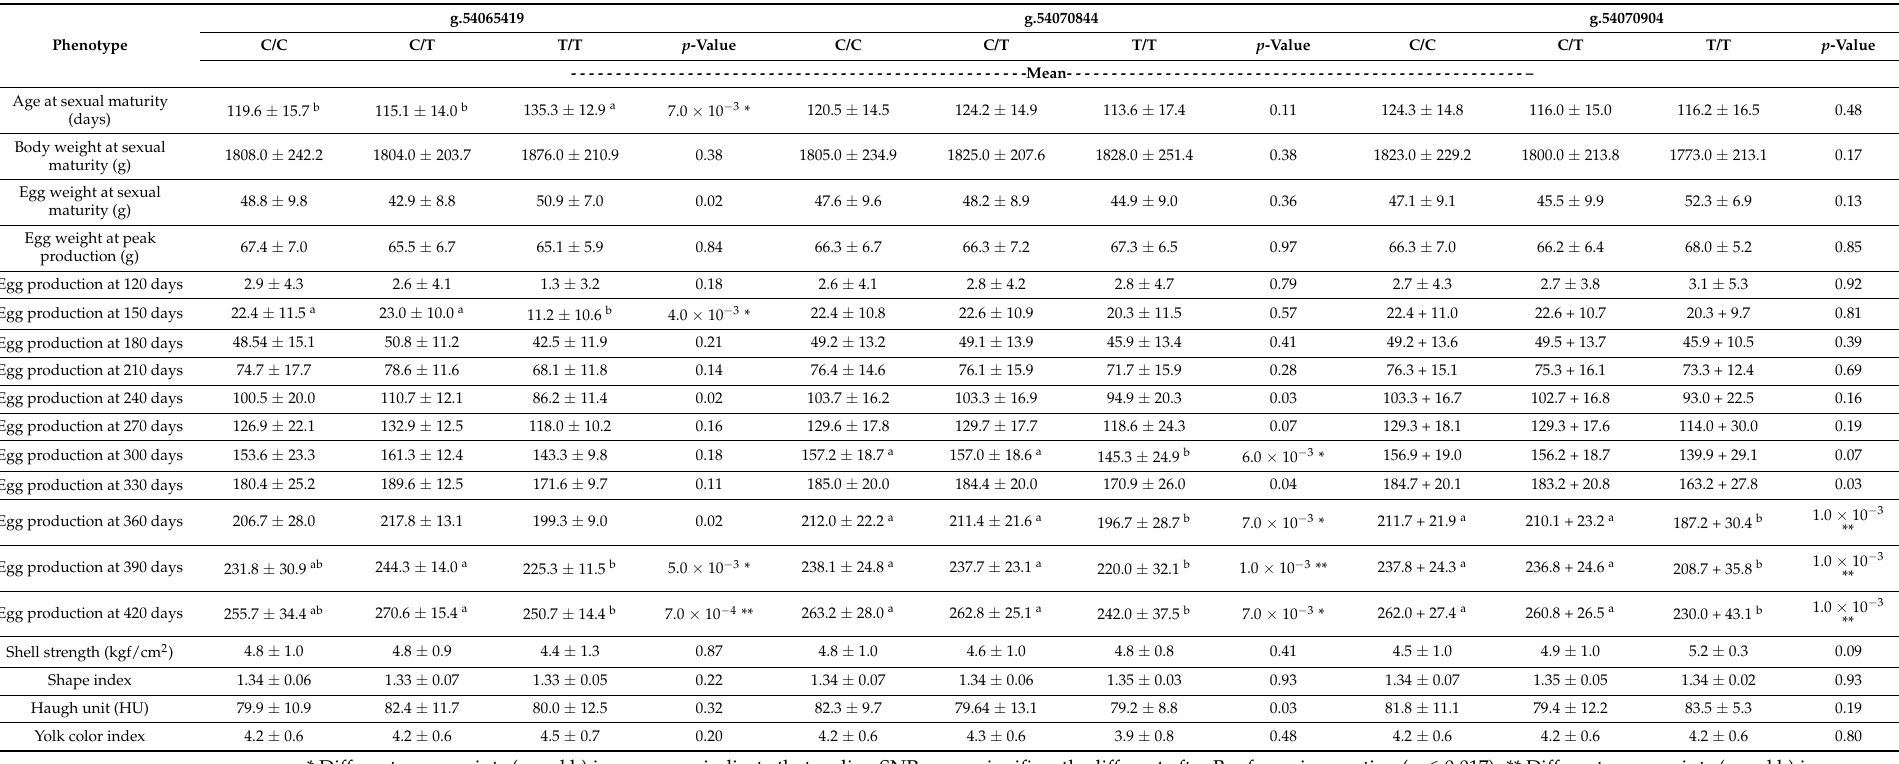
Table A1. Association Analysis between Reproductive Traits and SOX10